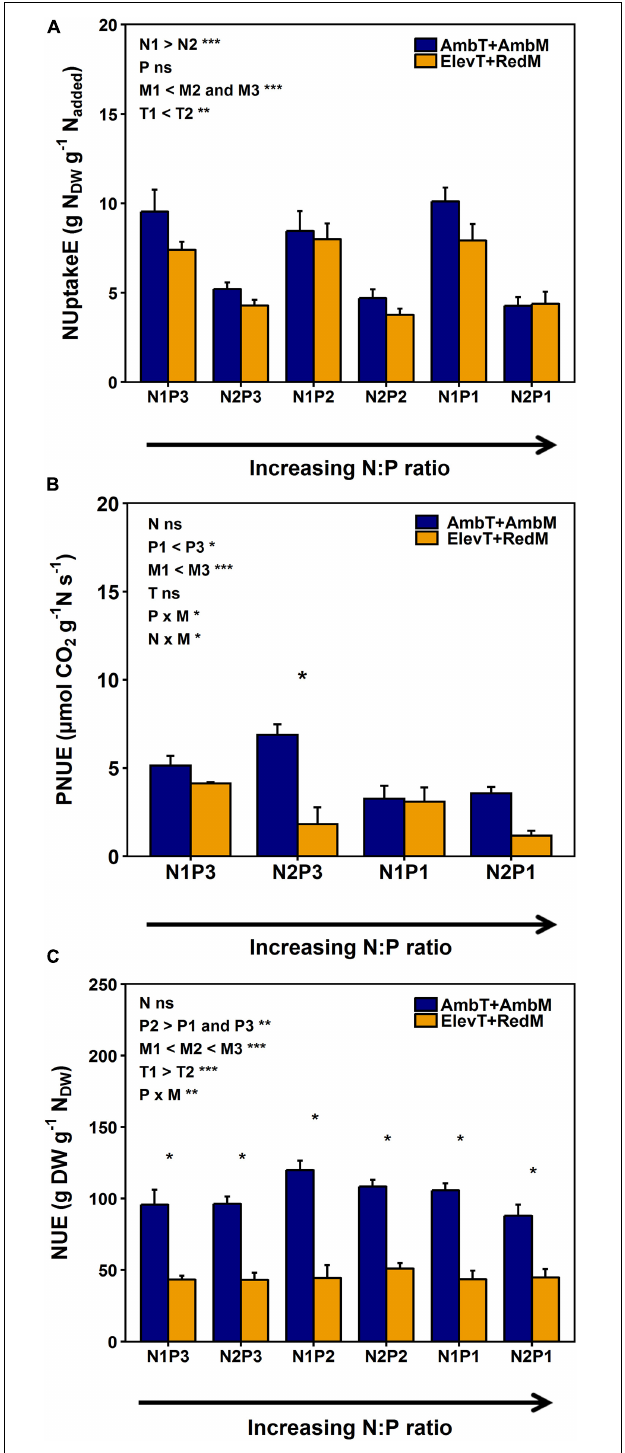
FIGURE 1 | Means and SE of (A) N uptake efficiency (NUptakeE), (B) , photosynthetic N use efficiency (PNUE), and (C) N use efficiency (NUE) of European beech saplings grown at increasing soil N:P ratios and ambient (dark bars; ambient temperature and soil moisture, AmbT + AmbM; treatment T1M3) or climate change conditions (light bars; elevated temperature and